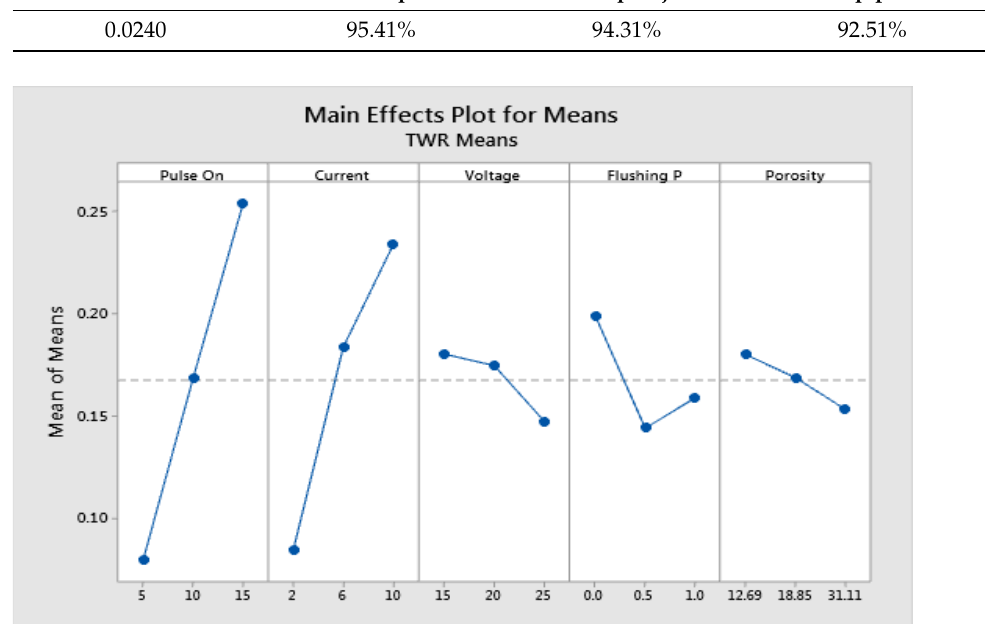
Figure 5. Main effect plot of factors for